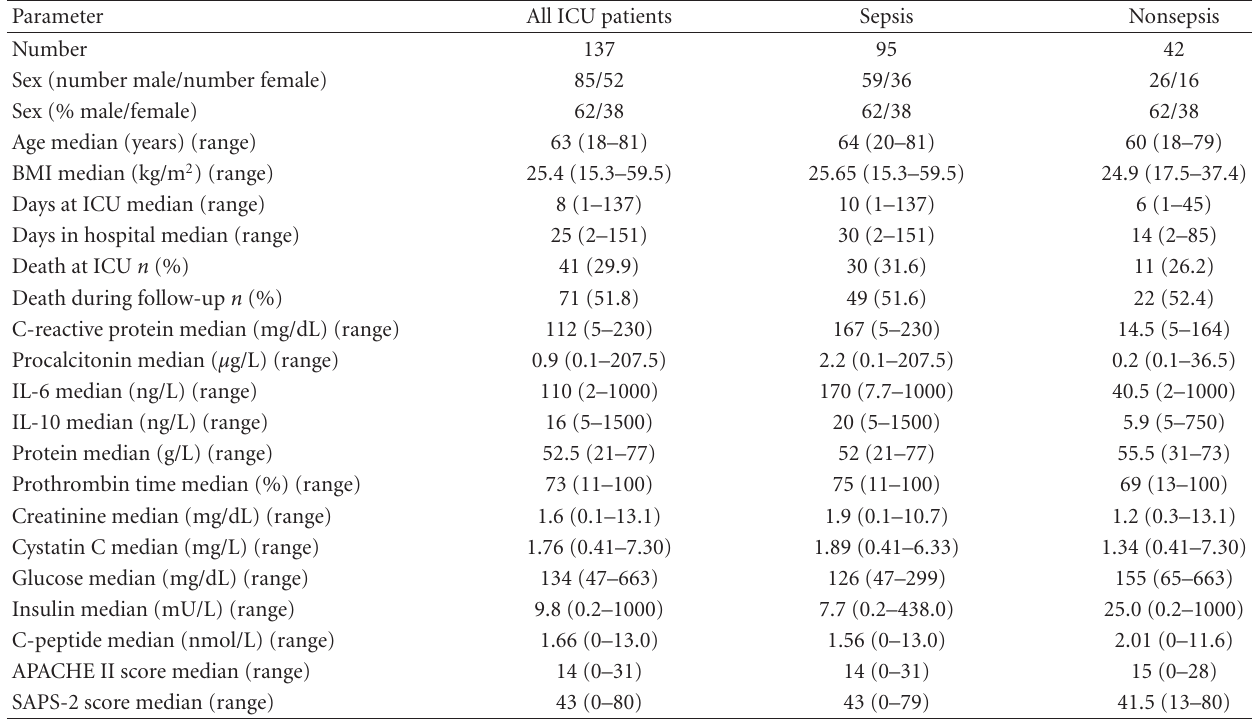
Table 1: Characteristics of the study